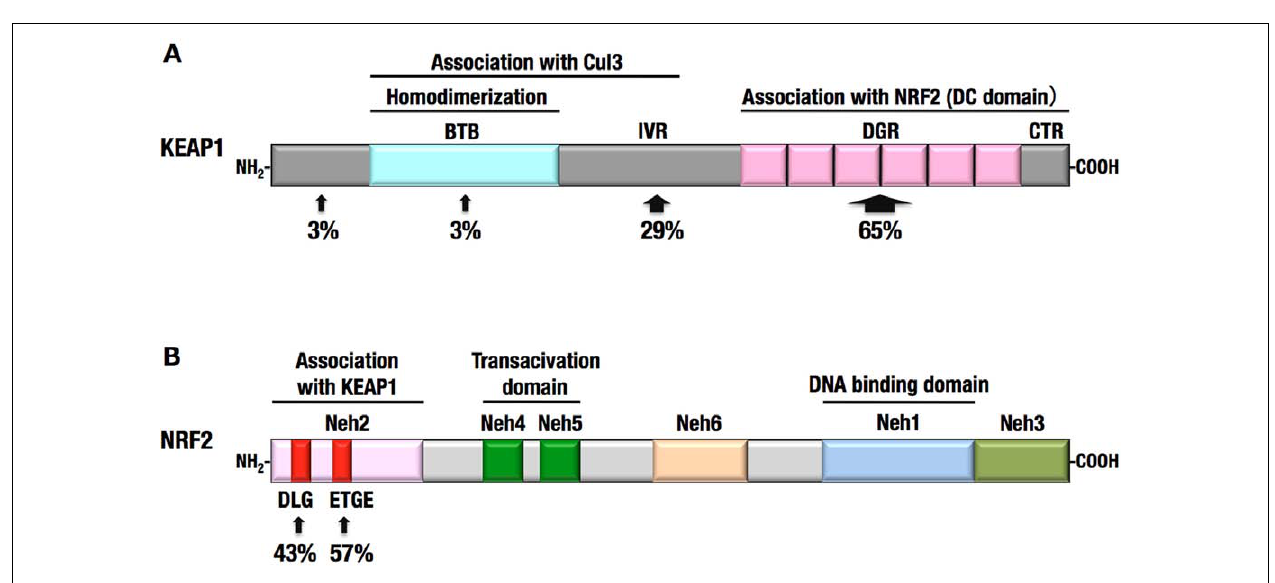
FIGURE 6 | Somatic mutations in KEAP1 and NRF2 genes identified in human cancers. (A) More than half of the KEAP1 gene mutations were identified in the DC domain. (B) All NRF2 gene mutations were restricted to the DLG and ETGE motifs.